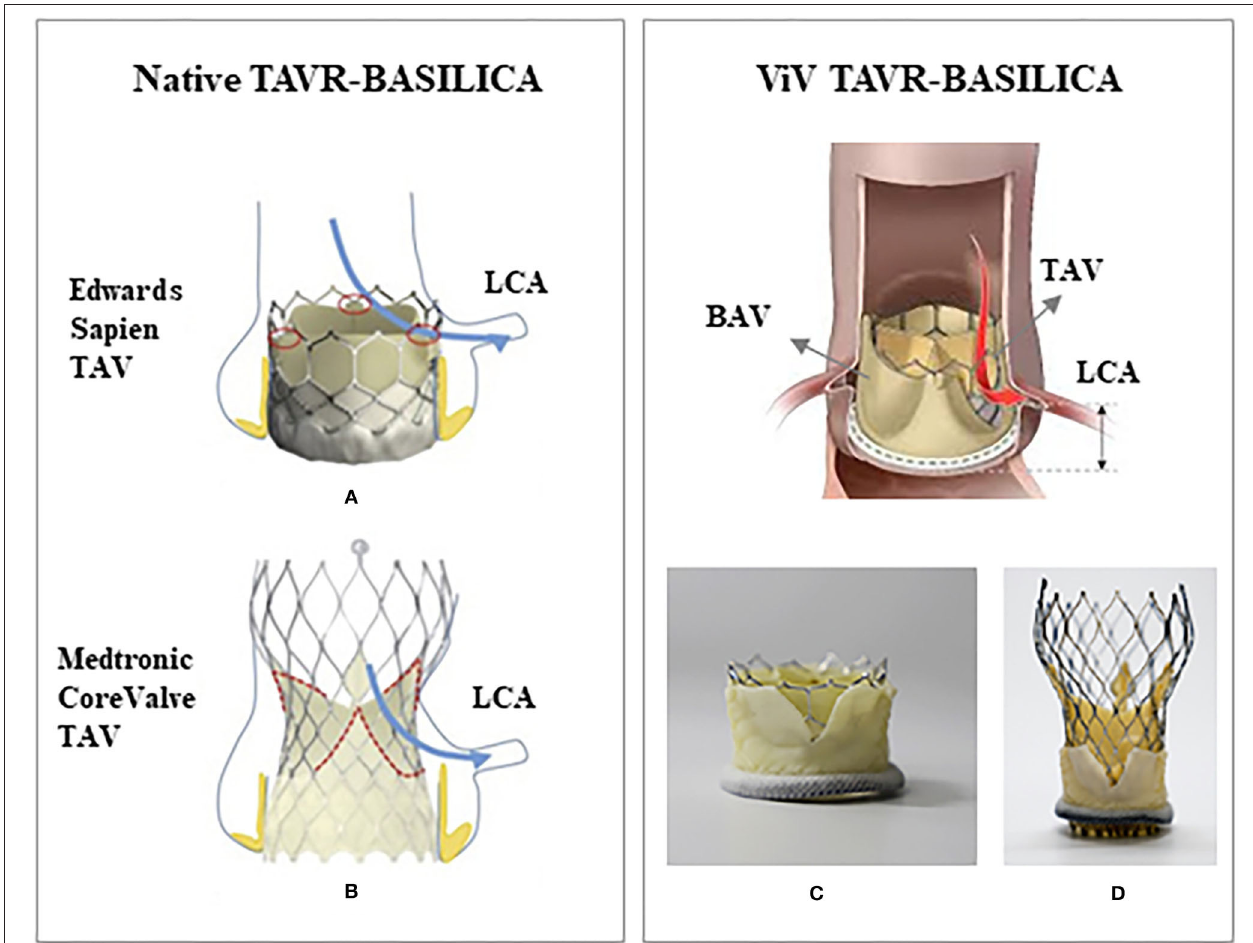
FIGURE 4 | Schematic of a native TAVR-BASILICA and a valve-in-valve TAVR-BASILICA: (A) a Edwards Sapien 3 transcatheter aortic valve (TAV) and (B) a Medtronic CoreValve Evolut R TAV replaced in a native aortic valve. (C) An Edwards Sapien 3 TAV and (D) a Medtronic CoreValve Evolut R TAV replaced in a bioprosthetic aortic valve (BAV). Red and blue arrows show the location of the lacerated leaflet (native or bioprosthetic) relative to the left coronary artery (LCA). (A,B) are from Krishnaswamy et al. (C,D) are from Khodaee et al. with permission.